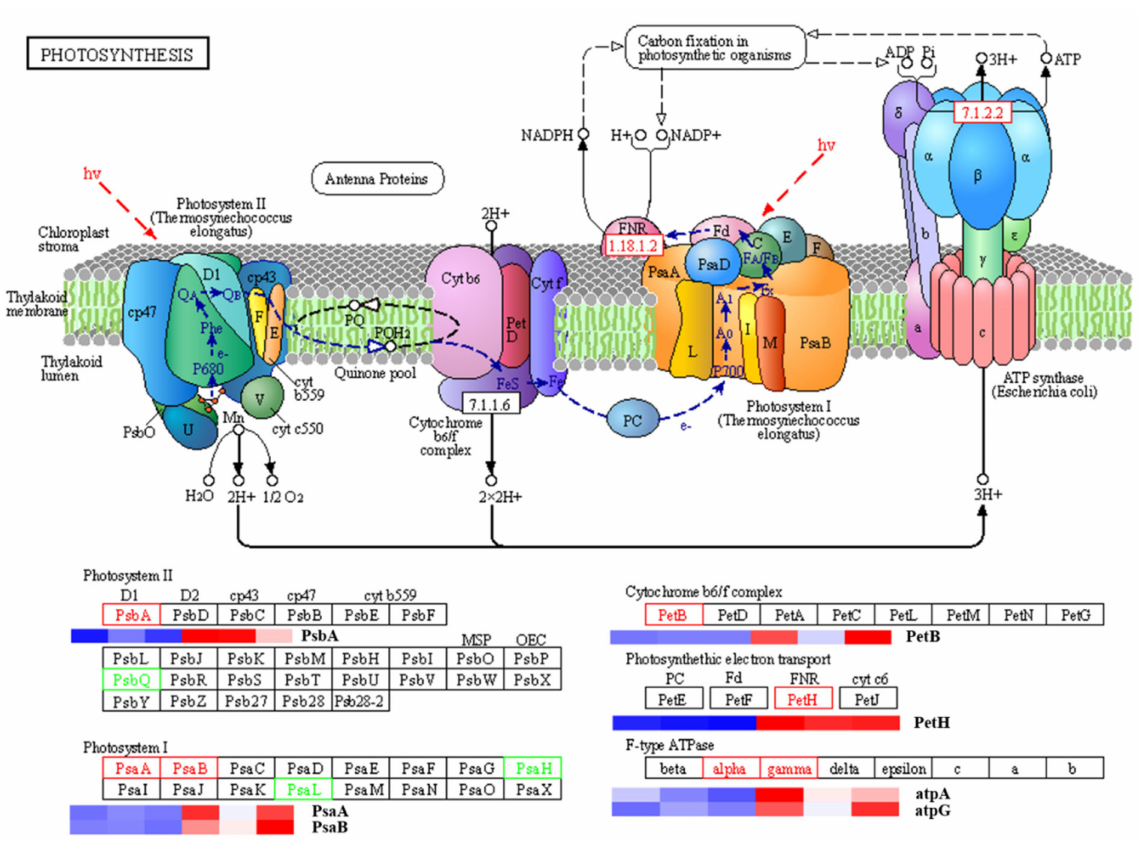
Figure 4. Summary of DEGs in the photosynthesis pathway in C. camphora treated with DFO. The bar represents the scale of the expression levels for each gene (FPKM) in the different treatments, as indicated by blue/red rectangles. Genes in blue show DFO treatment (upregulation), and those in red show CK treatment